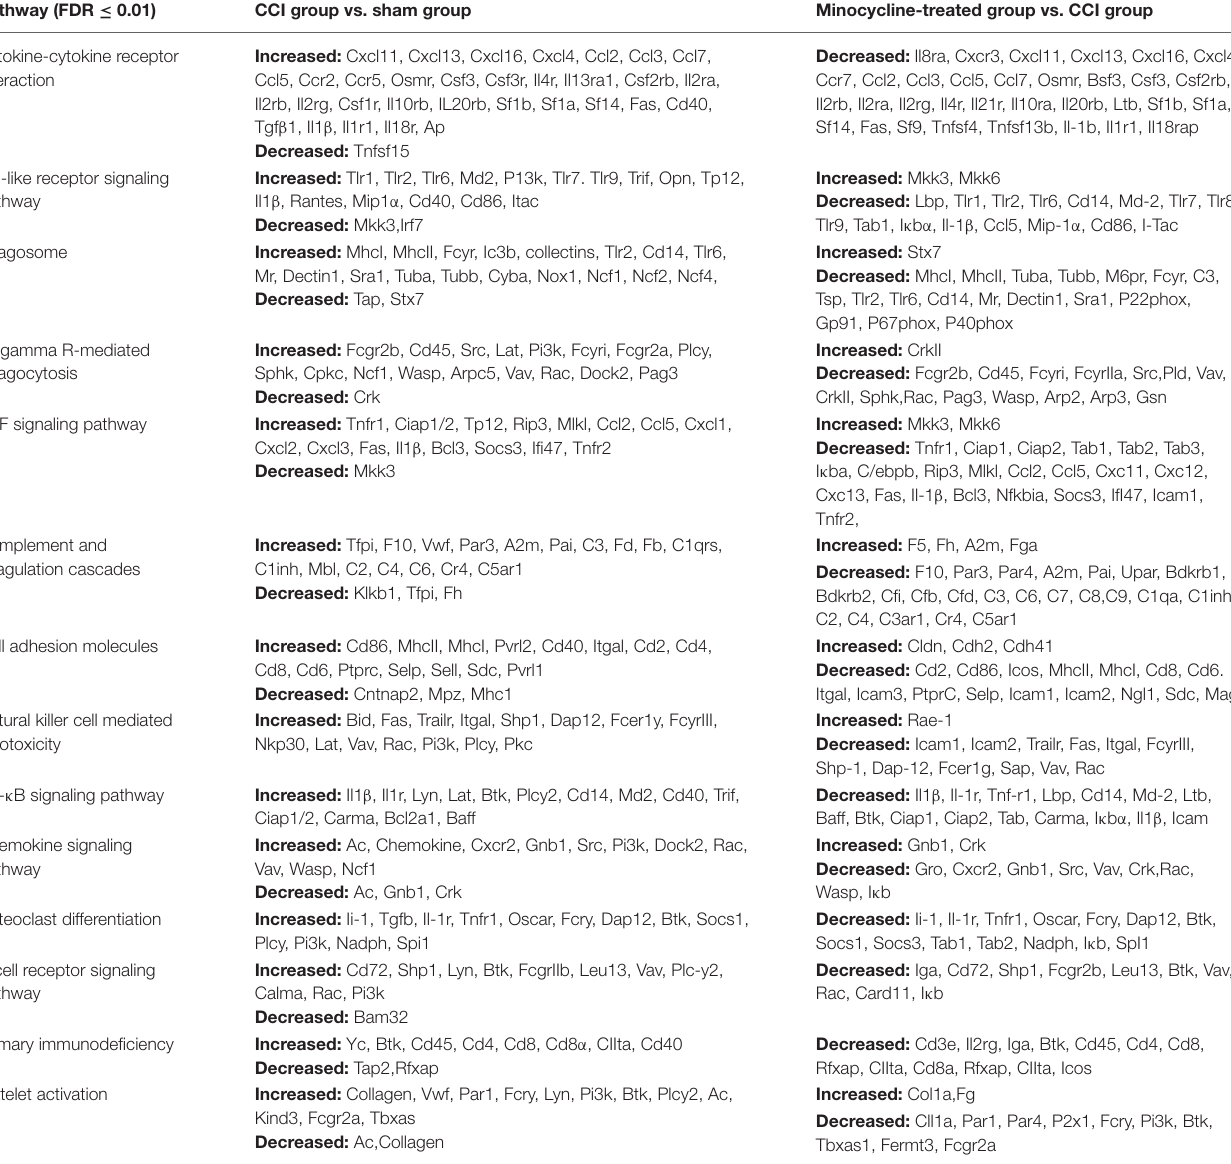
TABLE 2 | The top 14 most significant KEGG pathways identified with increased and decreased genes among different groups. Pathway (FDR ≤